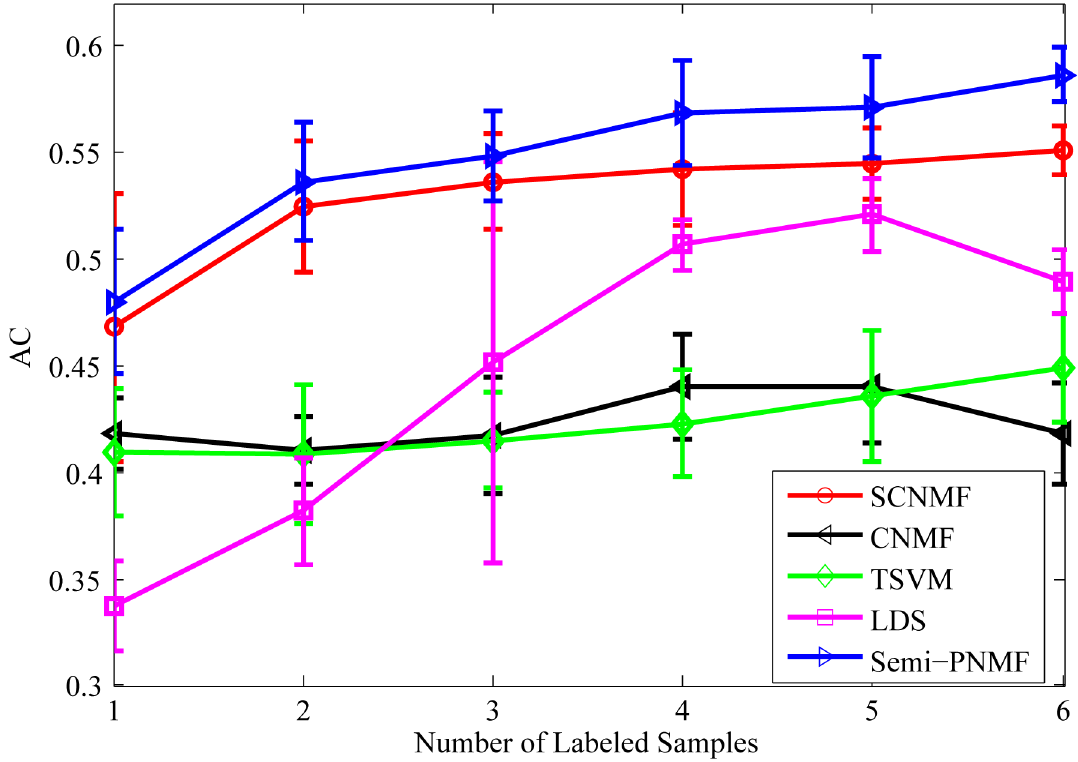
Fig 14. Average accuracies versus different numbers (1 – 6) of the labeled samples for each class on the Acute Leukemia